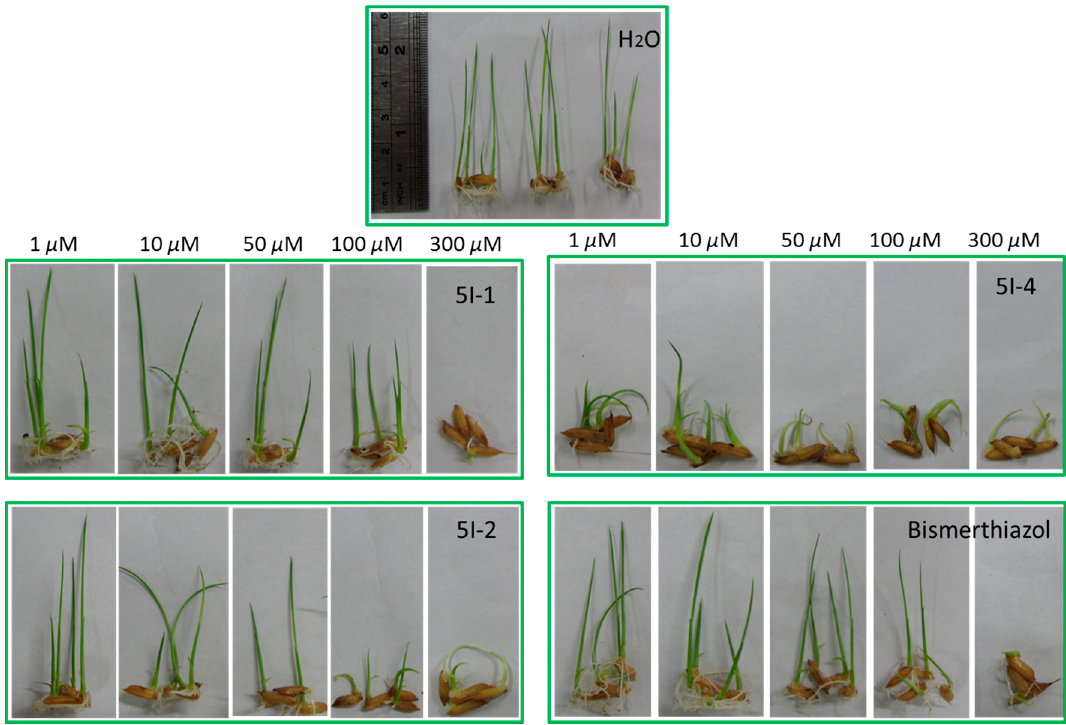
Figure 4. Phytotoxicity assay on rice seeds germination.